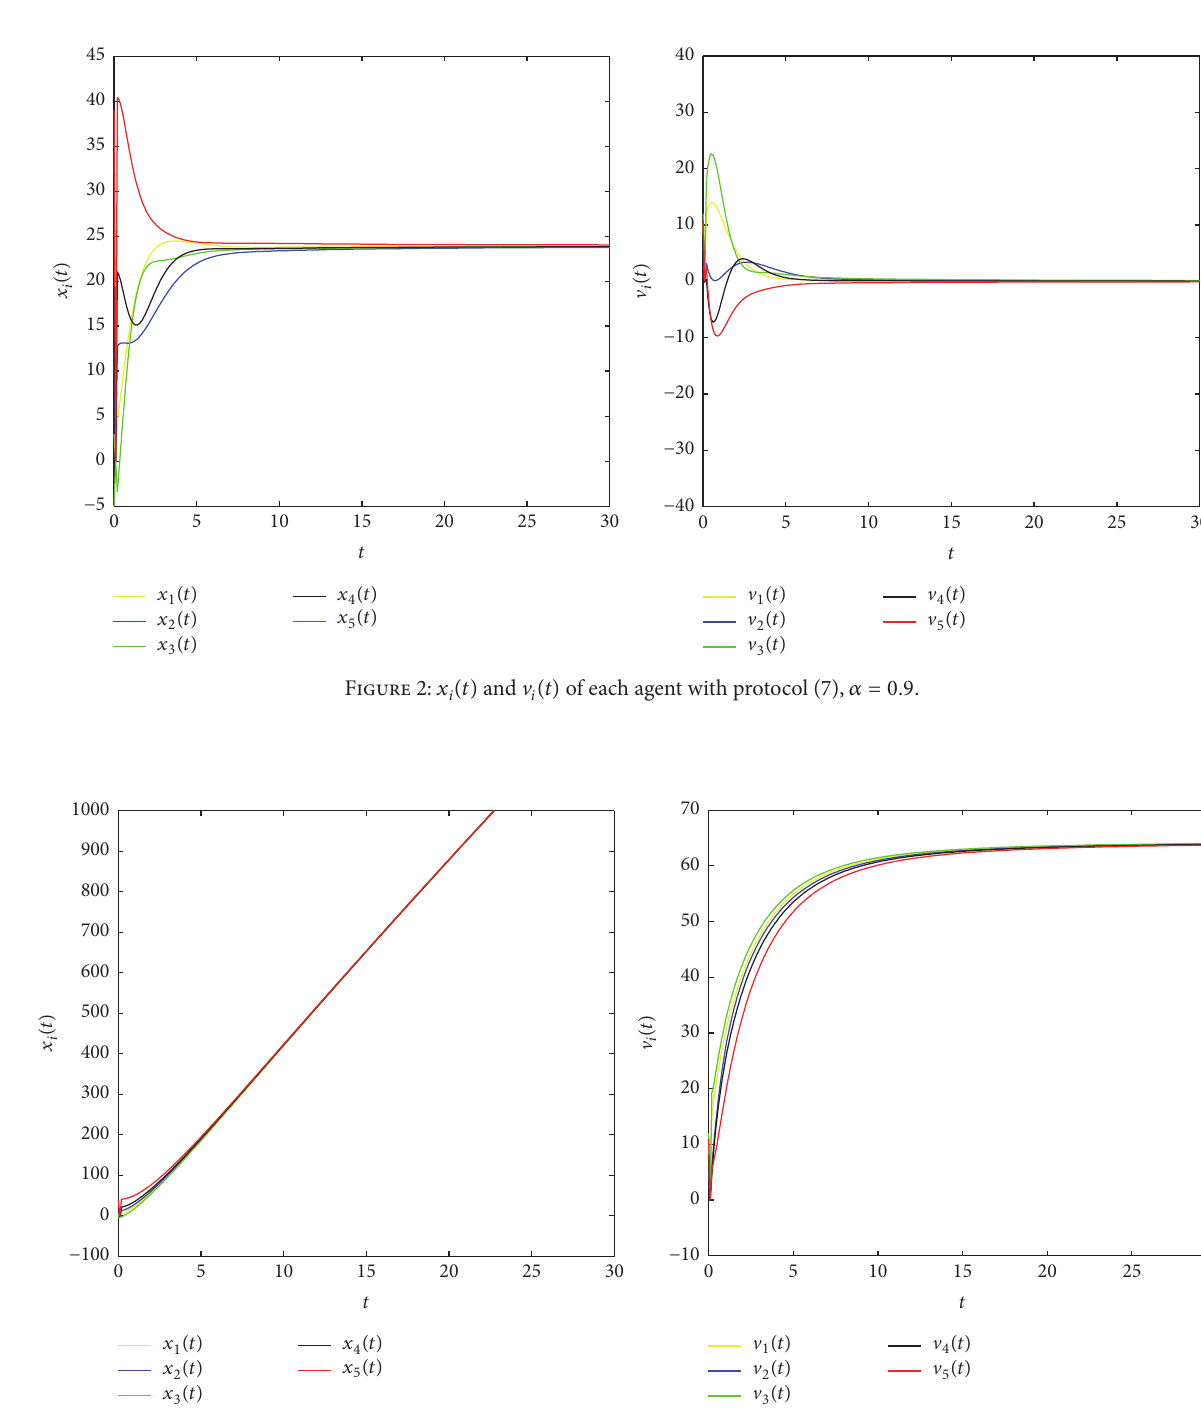
Figure 3: 𝑥 𝑖 (𝑡) and V 𝑖 (𝑡) of each agent with protocol (22), 𝛼 = 0.9